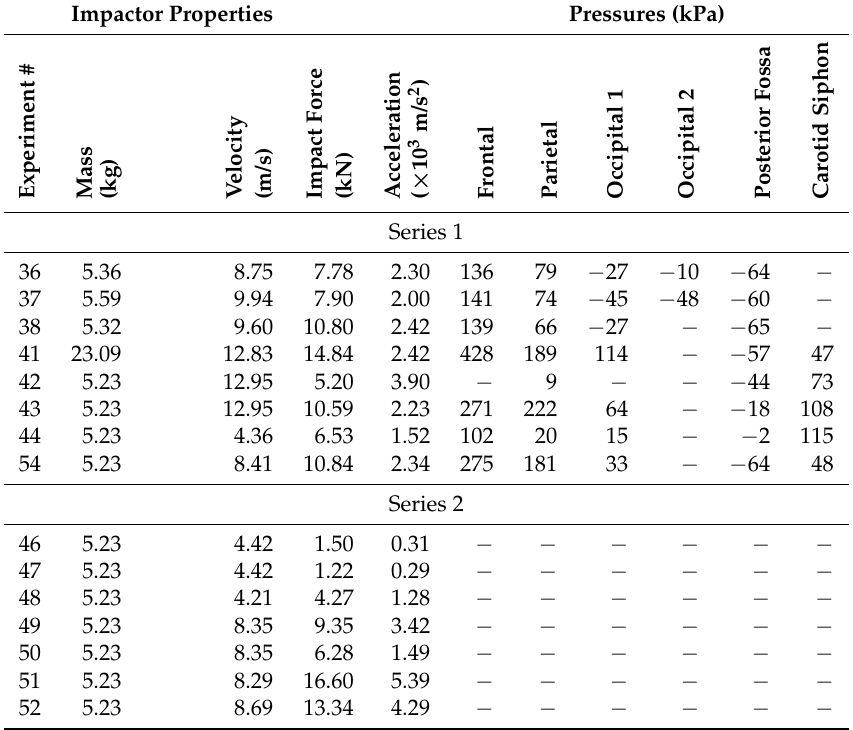
Table 1. Summary of impact conditions and peak response values across all scenarios tested experimentally on cadavers by Nahum et al.